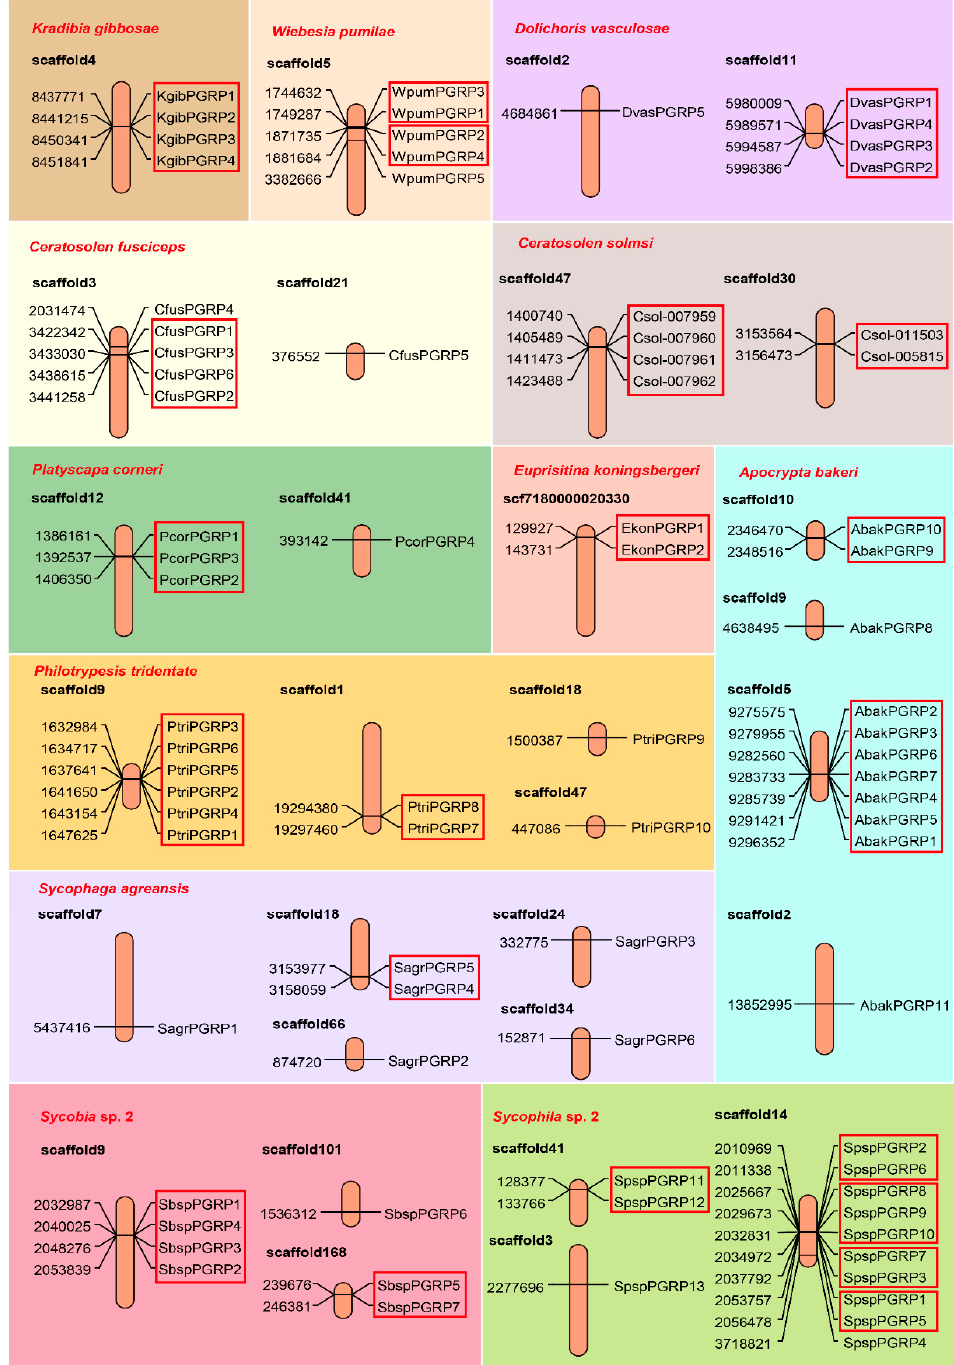
Figure 1. Schematic image showing the genomic localizations of the PGRP genes on the genomes of the 12 fig wasps. The location patterns could well declare tandem duplication events of PGRP genes in most fig wasp species. Each box of background color presented the results of one fig wasp species, and the orange columns are scaffolds. The gene names are listed in the right (the tandem genes were enclosed in red boxes), and their locations (the number represented the position of the gene start position on the scaffold) are marked on the left.